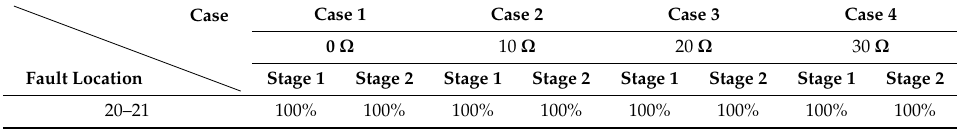
Table 11. Accuracy of fault location according to the installation of PMU in the lateral feeder 3.